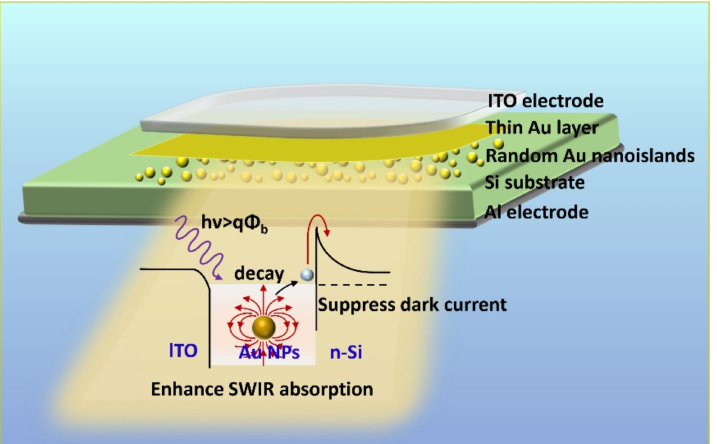
Figure 1. The schematic view of the structure of the ITO/Au/Au NPs/n-Si PD and the mechanism of performance